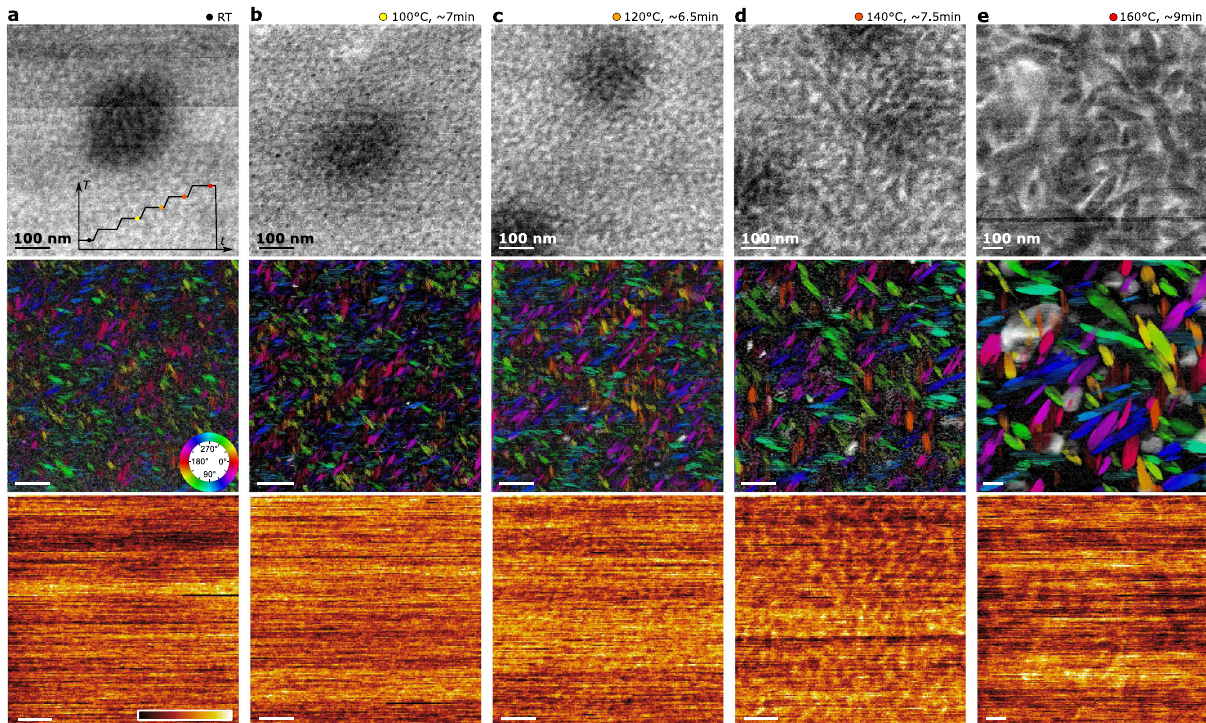
Fig. 5 Observing the structural evolution upon thermal annealing of DRCN5T:PCBM thin fi lm in the TEM. A continuous “ ramp-and-hold ” temperature pro fi le (inset in a) was applied. The data at each stage is visualized in columns ( a – e ), with the holding temperature and time indicated. The top raw show the simultaneously acquired ADF image; the middle and bottom rows are visualized 4D-SCED datasets using the same scheme as in Fig. 4. Scale bars: 100 nm. Note that the fi eld of view in e was increased during experiment to increase the chance to capture face-on